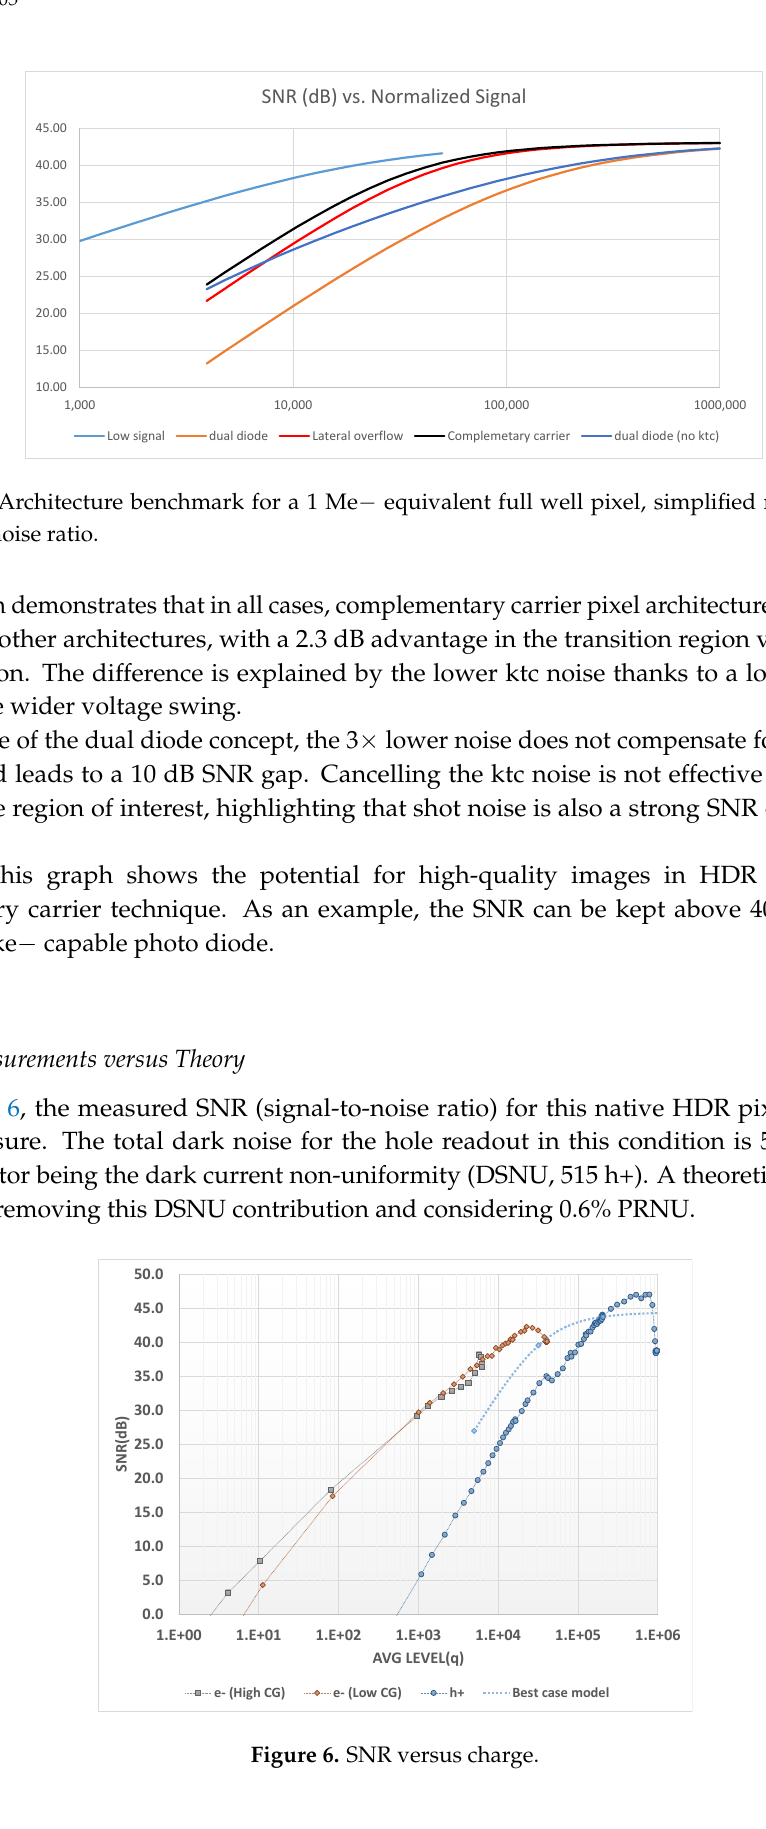
Figure 6. SNR versus charge.